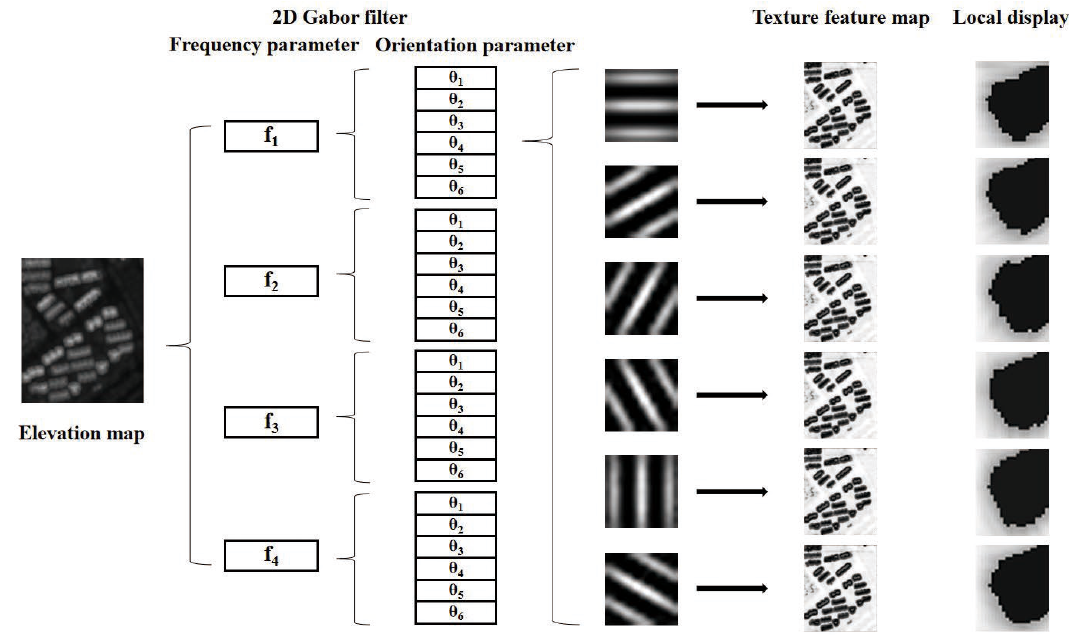
Figure 8. Texture features extraction using the Gabor filter.